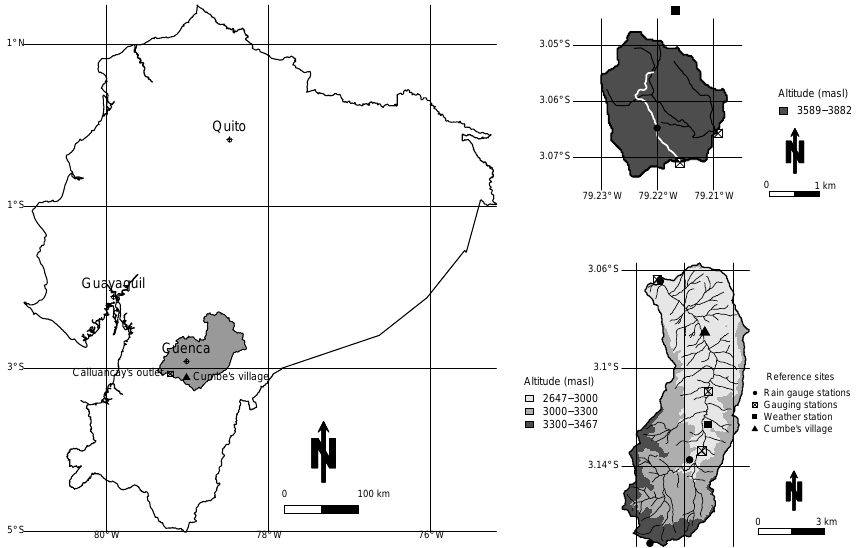
Figure 1. The study